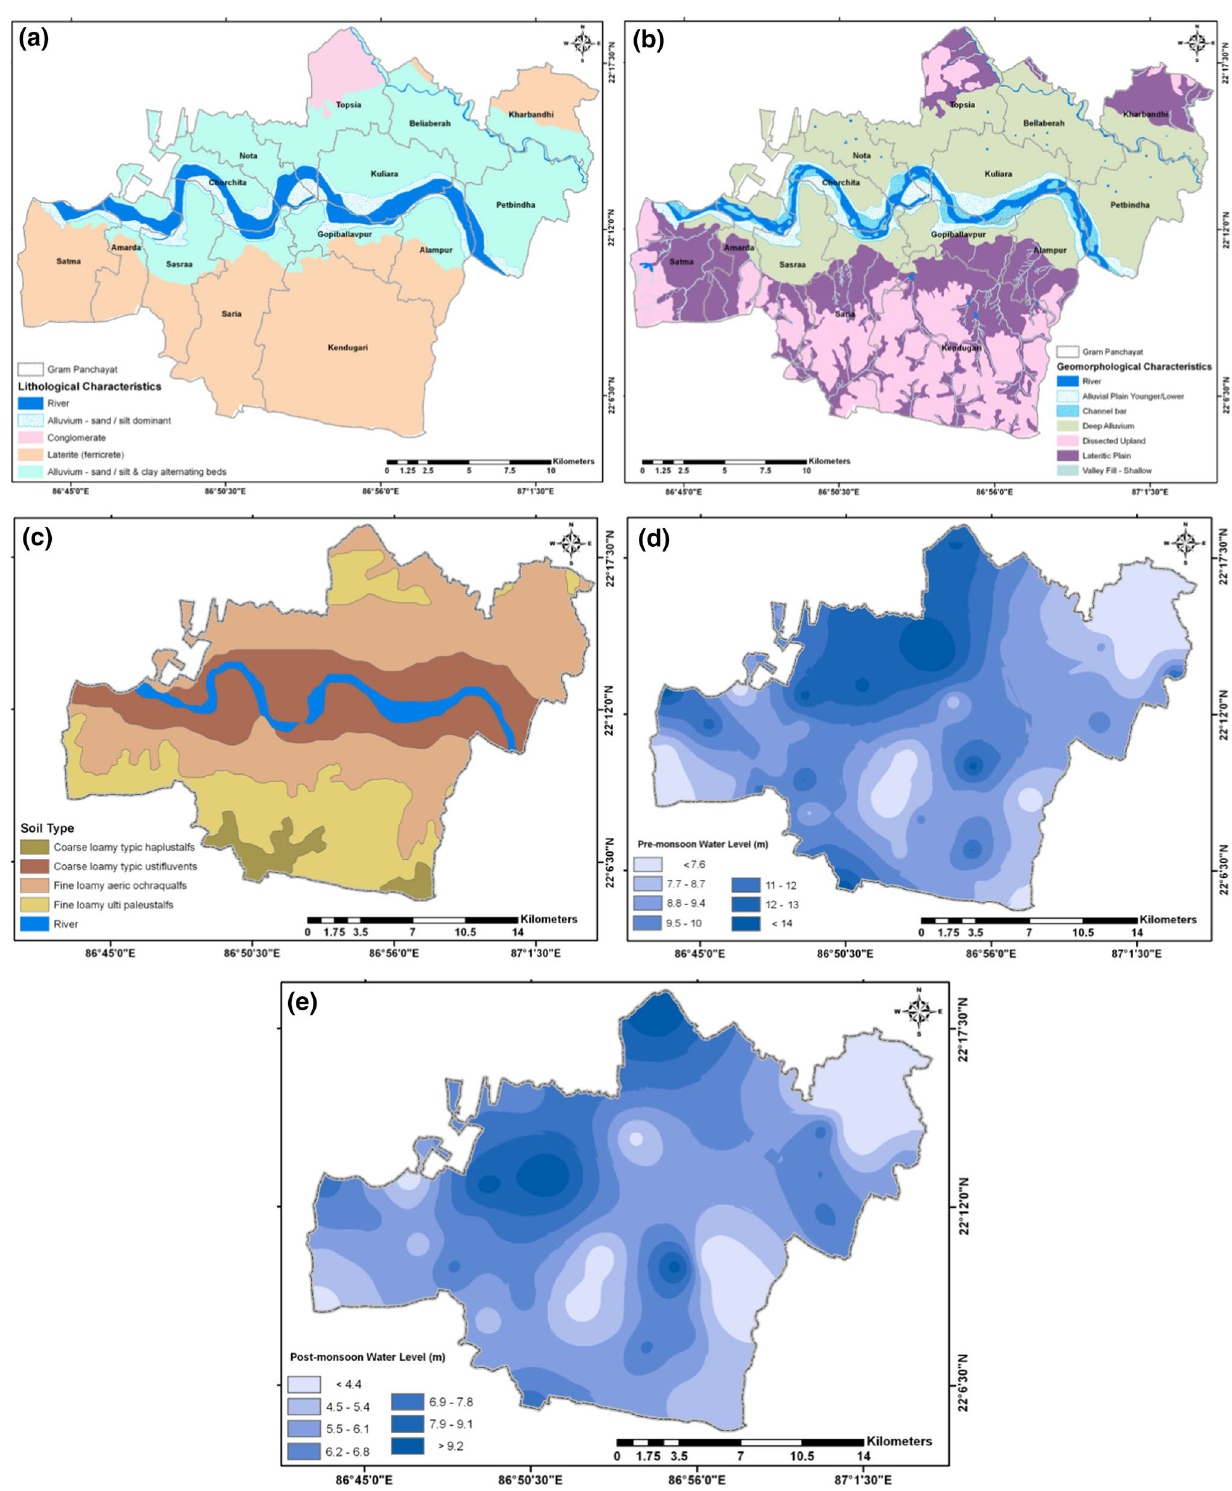
Fig. 4 Thematic layers of environmental variables in relation to groundwater potentiality a lithology, b geomorphology c soil d pre-monsoon water level e post-monsoon water